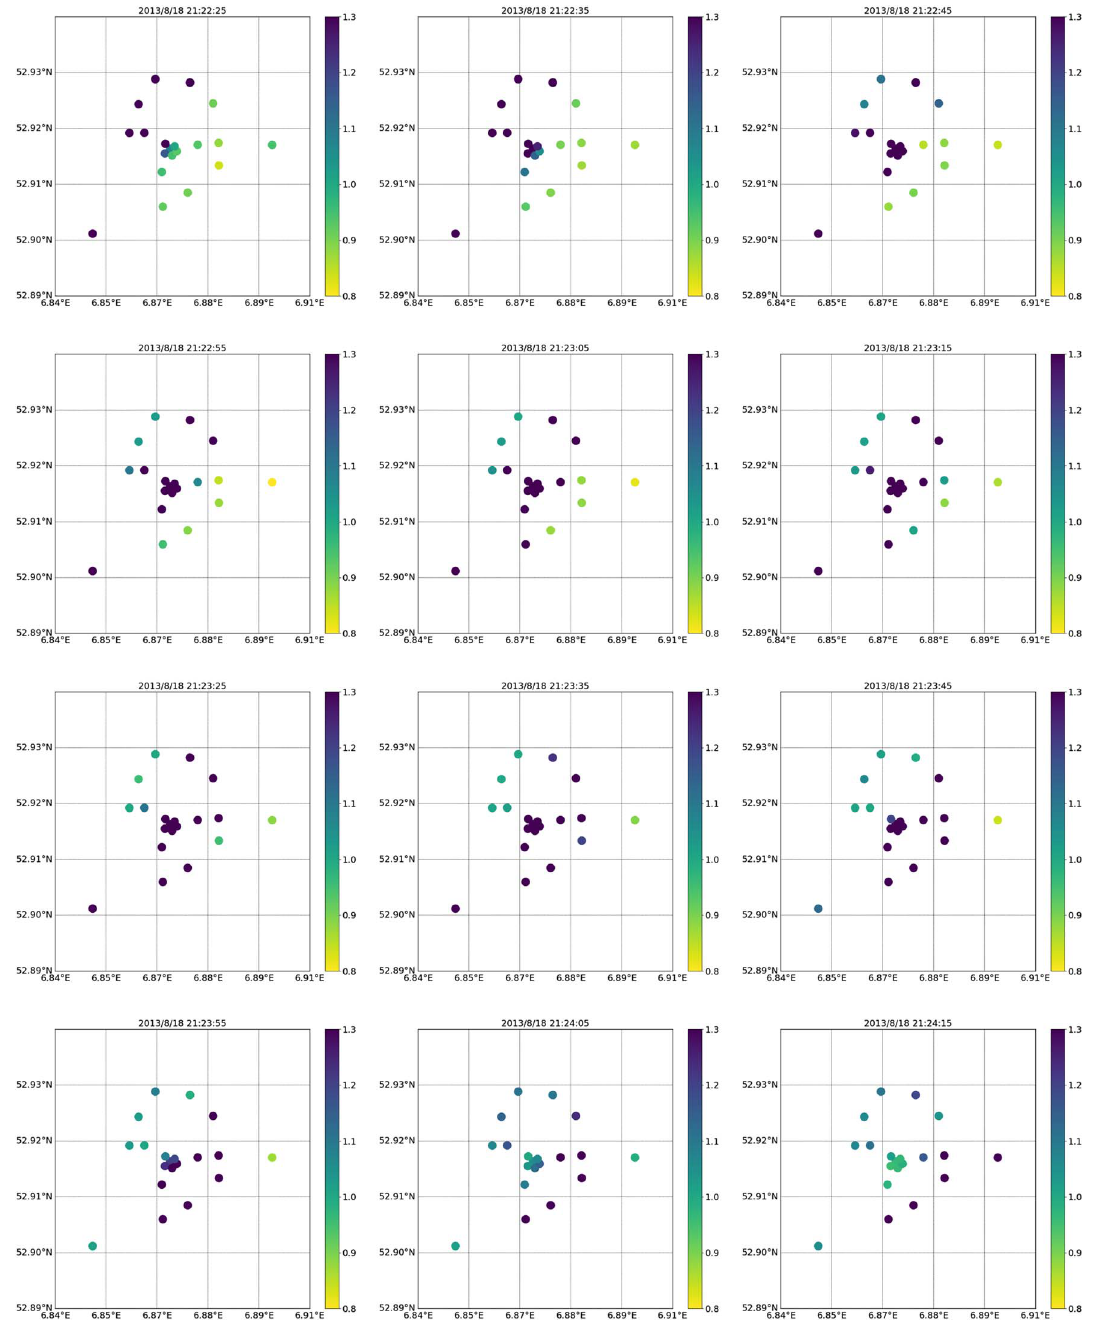
Fig. 5. Normalised intensities received by all core stations at an observing frequency of 44.13 MHz, plotted on a geographical map of the stations. The intensities are colour-coded using a colour scale from yellow to purple with a range of 0.8 – 1.3 respectively. Times are at ~10 s intervals from 21:22:25 UT at top left to 21:24:15 UT at bottom right, and each plot uses data samples with an integration time of 0.92 s. Plot diameter is ~4.5